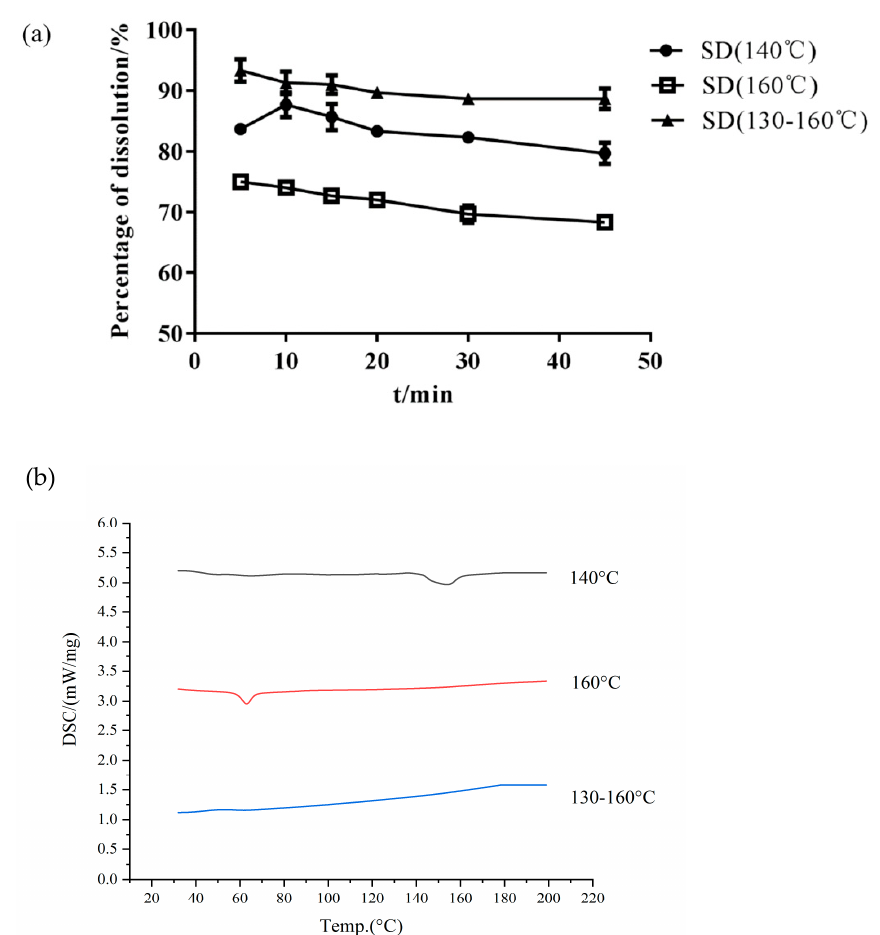
Figure 4. The dissolution of SD ( a ) and DSC curves ( b ) under different temperature control condi- tions. Table 1. The preparation process of the Cur-EPO SD. Barrel Temperature/ °C Screw Speed/rmp Cooling Method The Content of Cur/%